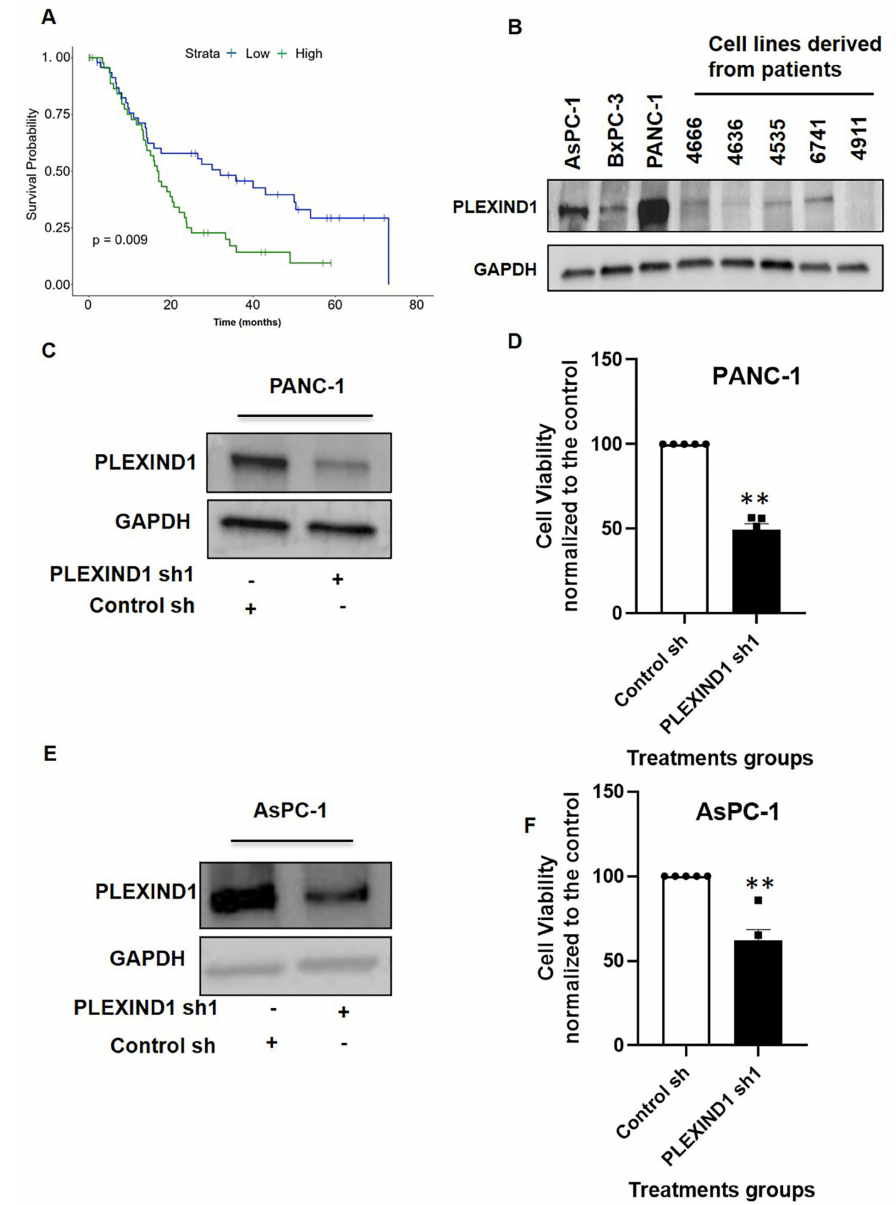
Figure 1. Expression pattern and functional role of PLEXIND1 in PDAC. ( A ): Survival probability analysis of pancreatic ductal adenocarcinoma (PDAC) patients with high and low levels of PLEXIND1 expression. ( B ): Western blot analysis of PLEXIND1 expression in commercial and patient-derived PDAC cell lines. ( C , E ): Western blot analysis of PLEXIND1 expression in PDAC cell line PANC-1 and AsPC-1 after shRNA treatment, respectively. ( D , F ): Cell viability assay for PANC-1 and AsPC-1 cells with and without PLEXIND1 knockdown grown in 2D cell culture for 72 h. Data are plotted as percentage of control cells. Statistical significance: ** p < 0.01 vs. control. Error bars represent standard error of the